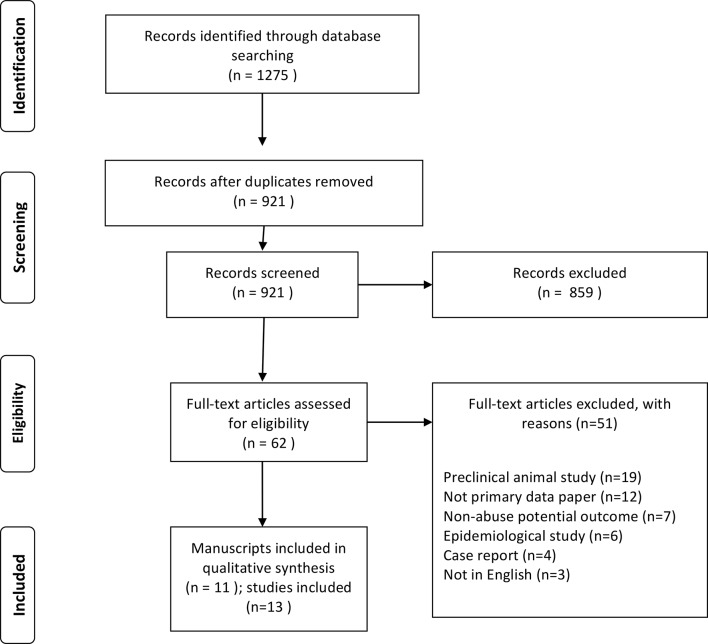
PRISMA Flowchart.